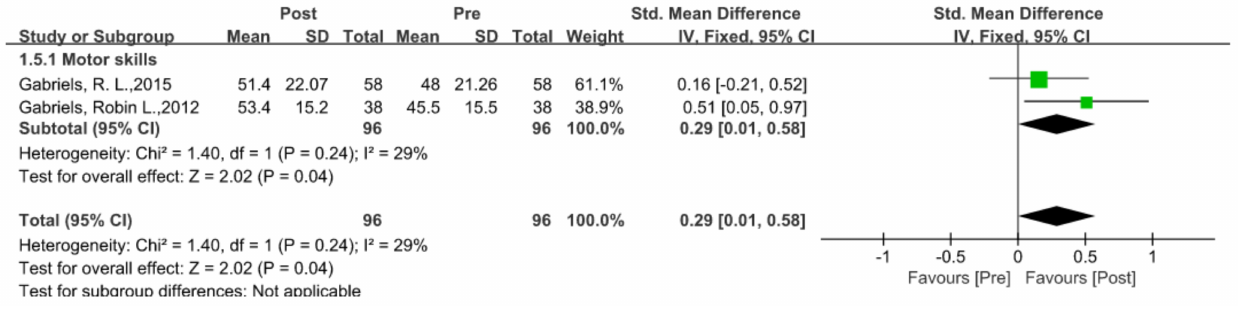
Figure 7. Forest plot of motor function (pre-post comparison) using BOT-2 [30,66].